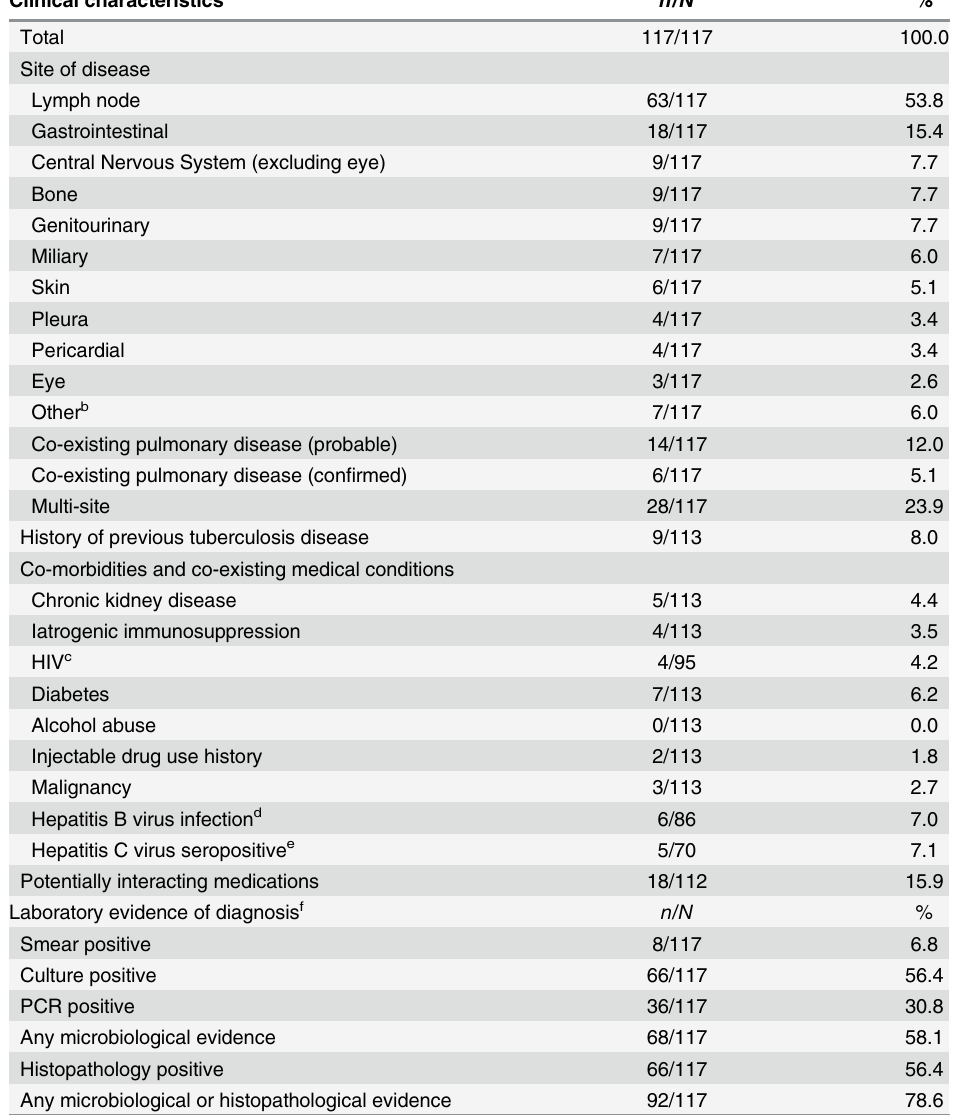
Table 2. Clinical characteristics and laboratory evidence of EPTB cases.